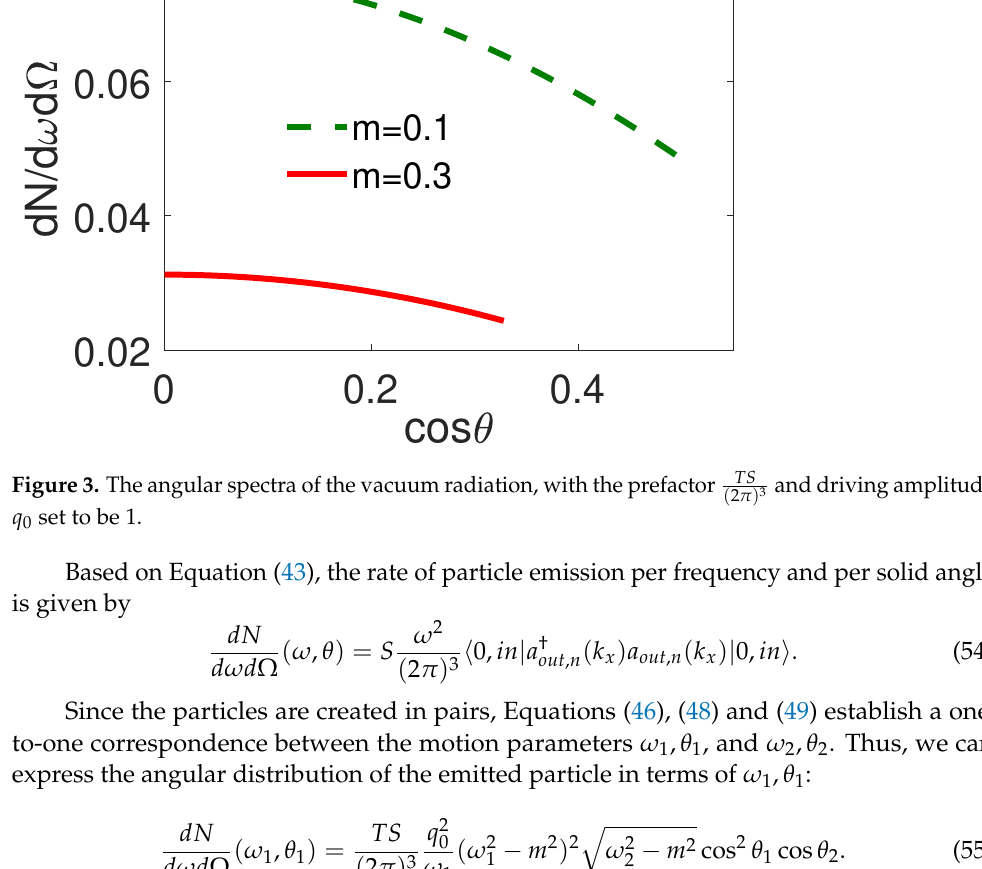
and driving amplitude ( 2 π ) 3